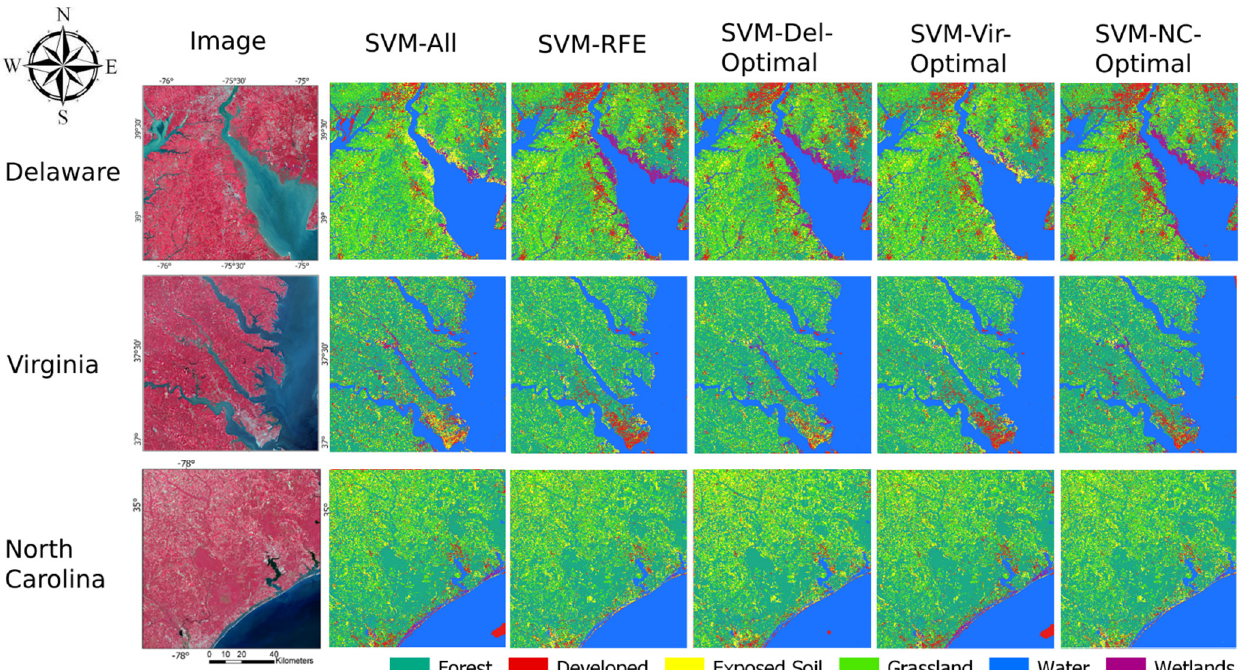
Figure 9. Example set of land cover classifications of the Delaware, Virginia, and North Carolina datasets trained from the large training sets using a variety of feature sets, including the full feature set (SVM-All), SVM-RFE, SVM-Del-Optimal, SVM-Vir-Optimal, and SVM-NC-Optimal. The Sentinel-2A imagery is displayed as a false-color composite with bands 8 (NIR), 4 (red), and 3 (green) depicted as RGB.